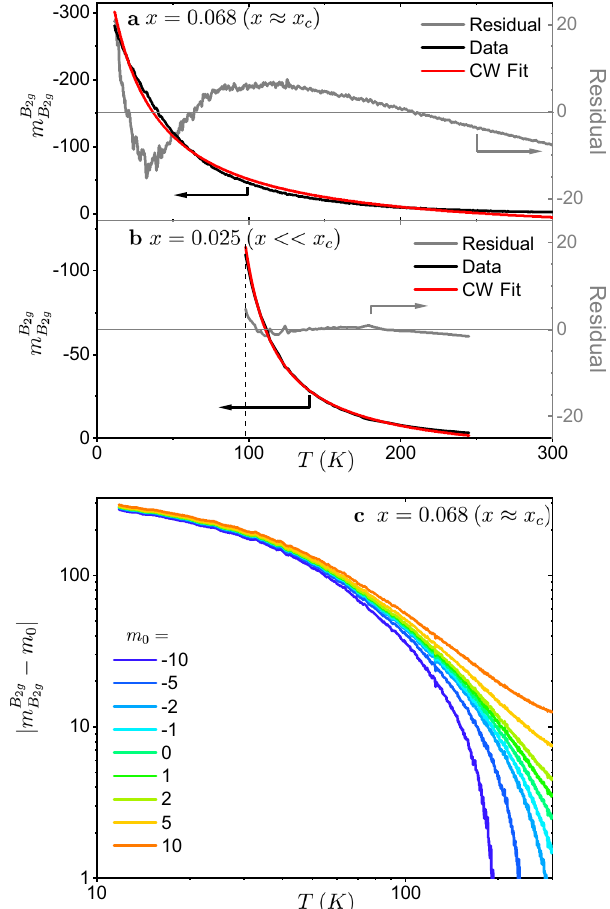
Fig. 4 The temperature dependence of m B 2 g for x = 0.068 ( x ≈ x c ) cannot be B 2 g j as a function of x − x for x = 0.068 (black line), the best described by a simple power law. a m B 2 g Fig. 3 Apparent power-law behavior of j m B 2 g B 2 g c . a A B 2 g / C þ m j vs. x − x Curie – Weiss fi t m B 2 g linear (blue axes) and logarithmic (red axes) plot of j m B 2 g ð T (cid:2) Θ Þ 0 (red line) and the associated residual B 2 g c at 13 K B 2 g j / j x (cid:2) x j (cid:2) ϕ (black lines). Error bars include the (gray line). There is a clear temperature dependence in the residual with power-law fi t j m B 2 g c B 2 g indicating that Curie – Weiss does not fully describe the temperature standard deviation of the measurement in addition to systematic errors. evolution. b m B 2 g for a far underdoped sample x = 0.025 (black line), the B 2 g best Curie – Weiss fi t (red line) and the associated residual (gray line). The data and fi t are taken from H.-H. Kuo et al. 18 . This sample has a structural transition at 98 K (dashed line). The magnitude of the residual is small compared to the residual shown in panel ( a ) indicating that Curie – Weiss is a reasonable approximation of the functional form. c Logarithmic plot of j m B 2 g